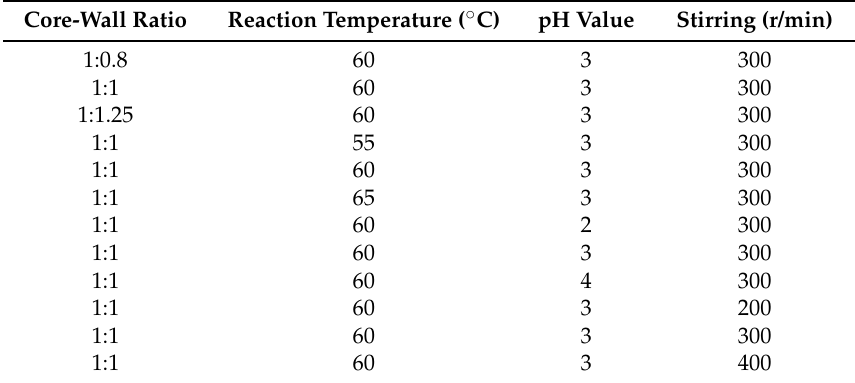
Table 1. Microcapsule preparation